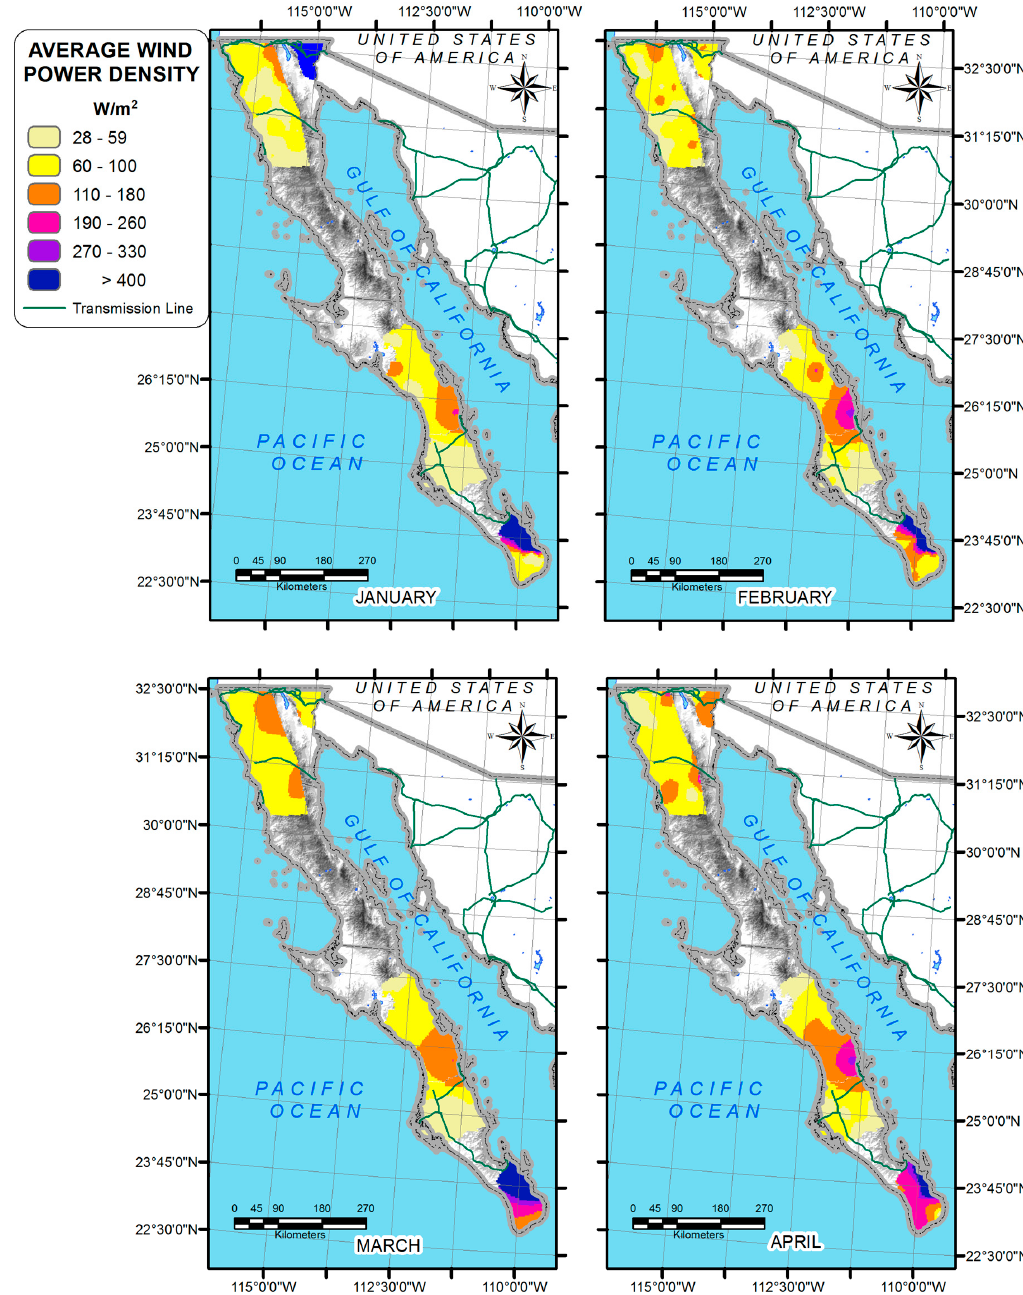
Figure 12. Average WPD from January to April.